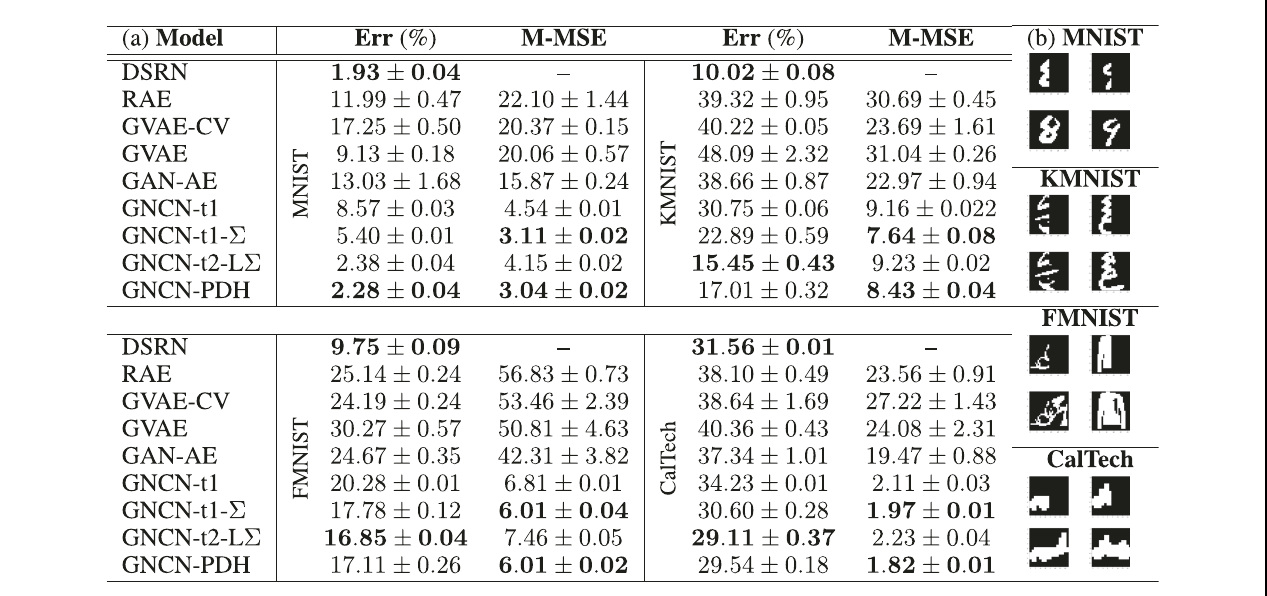
(a) The classi fi cation error (Err) of a log-linear model fi t to each model ’ s latent codes and the masked mean squared error (M-MSE) of the model ’ s pattern completion ability on the test set are reported (lowerisbetter — thetwobest scoresareshowninboldfontwithrespect toeachmetric/column).Metricsareaveragedover10trials — wereport theirmeanand standarddeviation.(b)For eachdatabase, we present for MNIST, KMNIST, FMNIST, and CalTech (in order from top to bottom) two randomly selected image patterns (from each dataset ’ s training split), which are shown in the fi rst row of each dataset ’ s table, and the GNCN-PDH ’ s completion of these patterns, displayed in the second row of each dataset ’ s table (note that GNCN-t1- Σ is the same as GNCN-t1- Σ /Friston and GNCN-t1 is the same